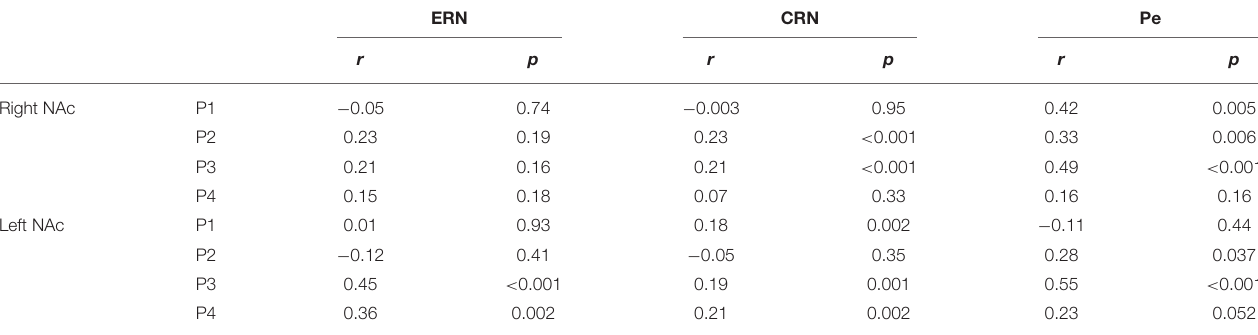
TABLE 4 | Spearman correlation of the error-related negativity (ERN), correct-related negativity (CRN) and Pe with the respective local field potentials in the